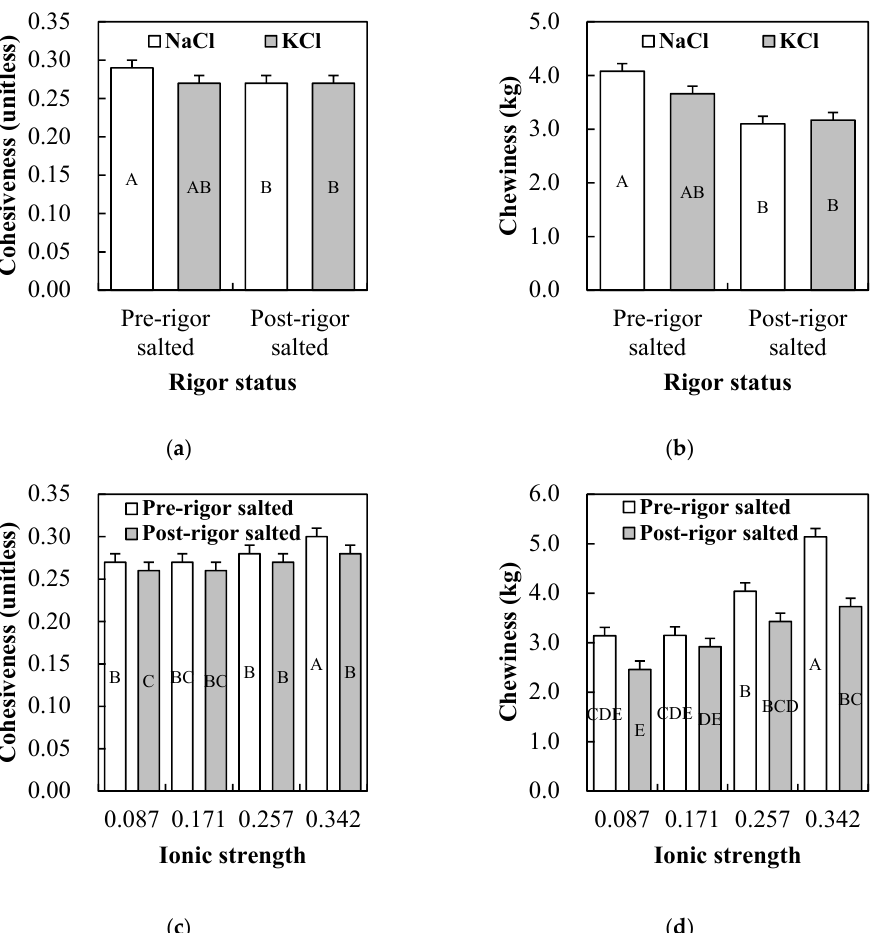
Figure 4. Salt type (NaCl vs. KCl) × rigor status (pre- vs. post-rigor salted) or rigor status (pre- vs. post-rigor salted) × ionic strength (0.087, 0.171, 0.257 vs. 0.34) interaction effects on cohesiveness ( a , c ) and chewiness ( b , d ) of salted chicken breasts. Error bars represent standard error of the means. A–E: means with the same letter are not significantly different ( p > 0.05).